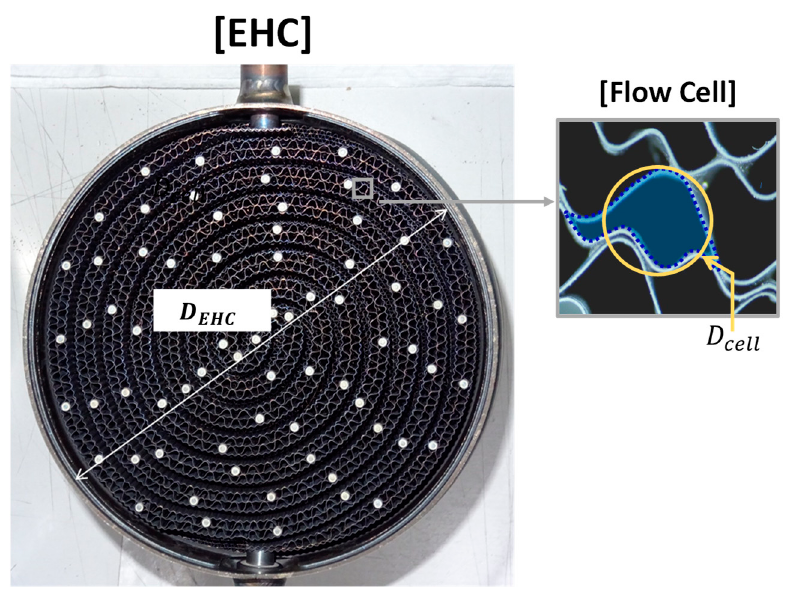
Figure 2. Structure of EHC in urea-SCR system.